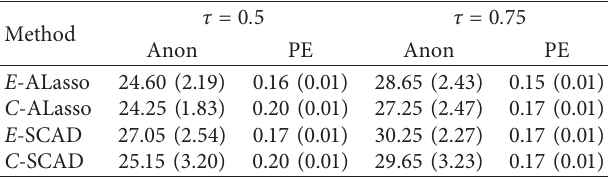
Table 3: Analysis of HIV drug susceptibility dataset. The numbers in parentheses are the corresponding standard deviations.